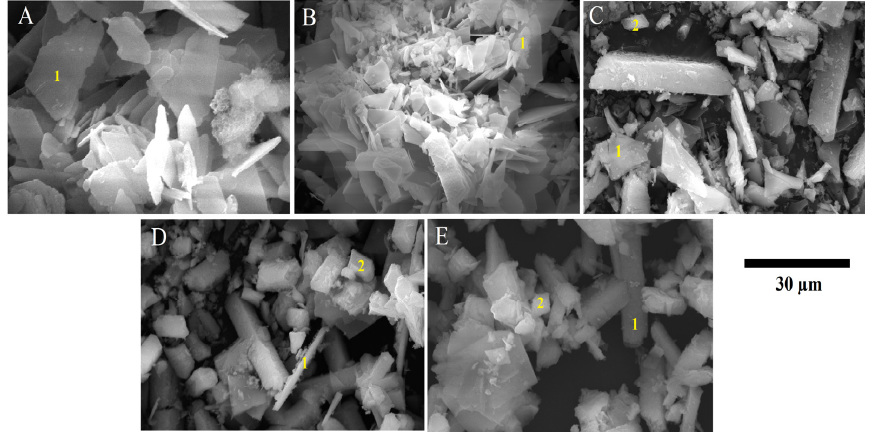
Figure 2. SEM images of Ca x Ni 1-x HPO 4 ·nH 2 O compounds (labeled using product names provided in Table 1 and obtained with the same magnification): ( A ) BNi0; ( B ) BNi2; ( C ) BNi4; ( D ) BNi5, and ( E ) BNi6. (Point 1—brushite crystals, Point 2—hexaaquanickel(II) hydrogenphosphate monohydrate).